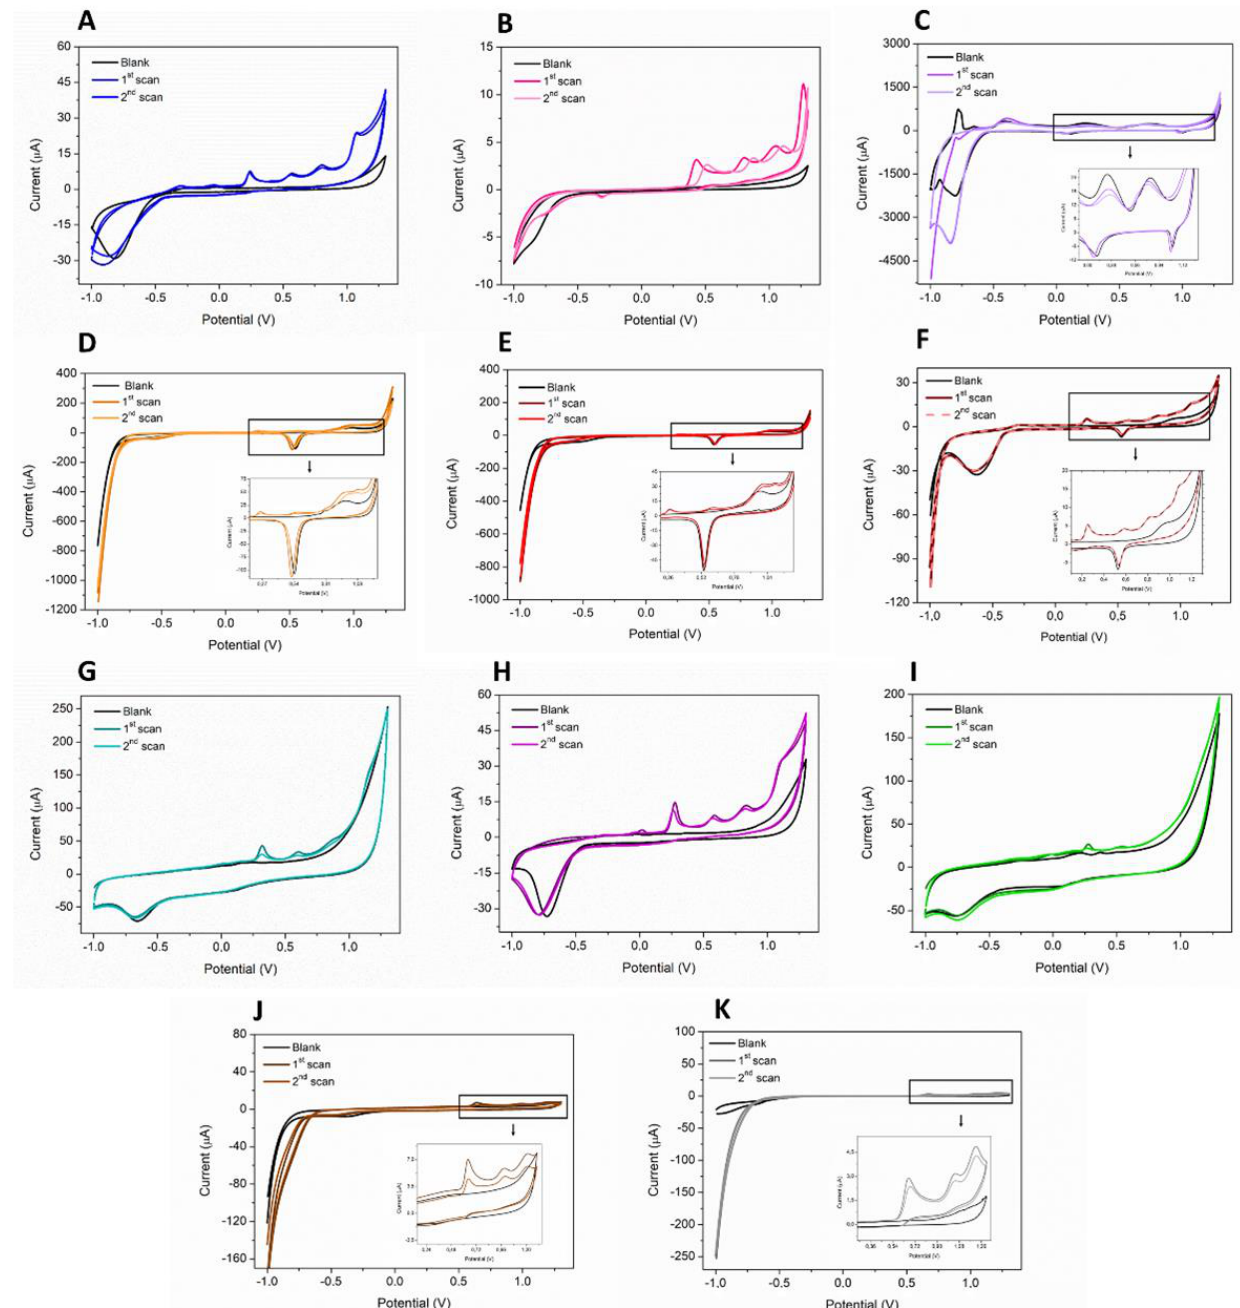
Figure 1. CVs of 50 µM PQS in 0.5 mM H 2 SO 4 on: ( A ) C-SPE, ( B ) BDD-SPE, ( C ) Pt-SPE, ( D ) C-SPE modified with 35 CV cycles of 5 mM HAuCl 4 , ( E ) C-SPE modified with 35 CV cycles of 1.5 mM HAuCl 4 , ( F ) GNP-SPE, ( G ) OMC-SPE, ( H ) CNT-SPE, ( I ) GPH-SPE, ( J ) GCE, and ( K ) CPE; SR 50 mV s −1 . Table 1. The height/position of the peaks obtained by CV of a 50 μM PQS in 0.5 M H 2 SO 4 on dif- ferent electrode materials (1st scan).